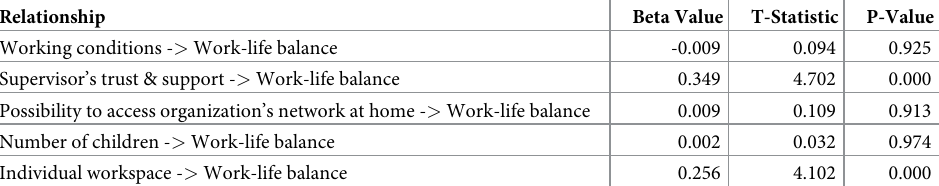
Table 5. Path coefficients of the